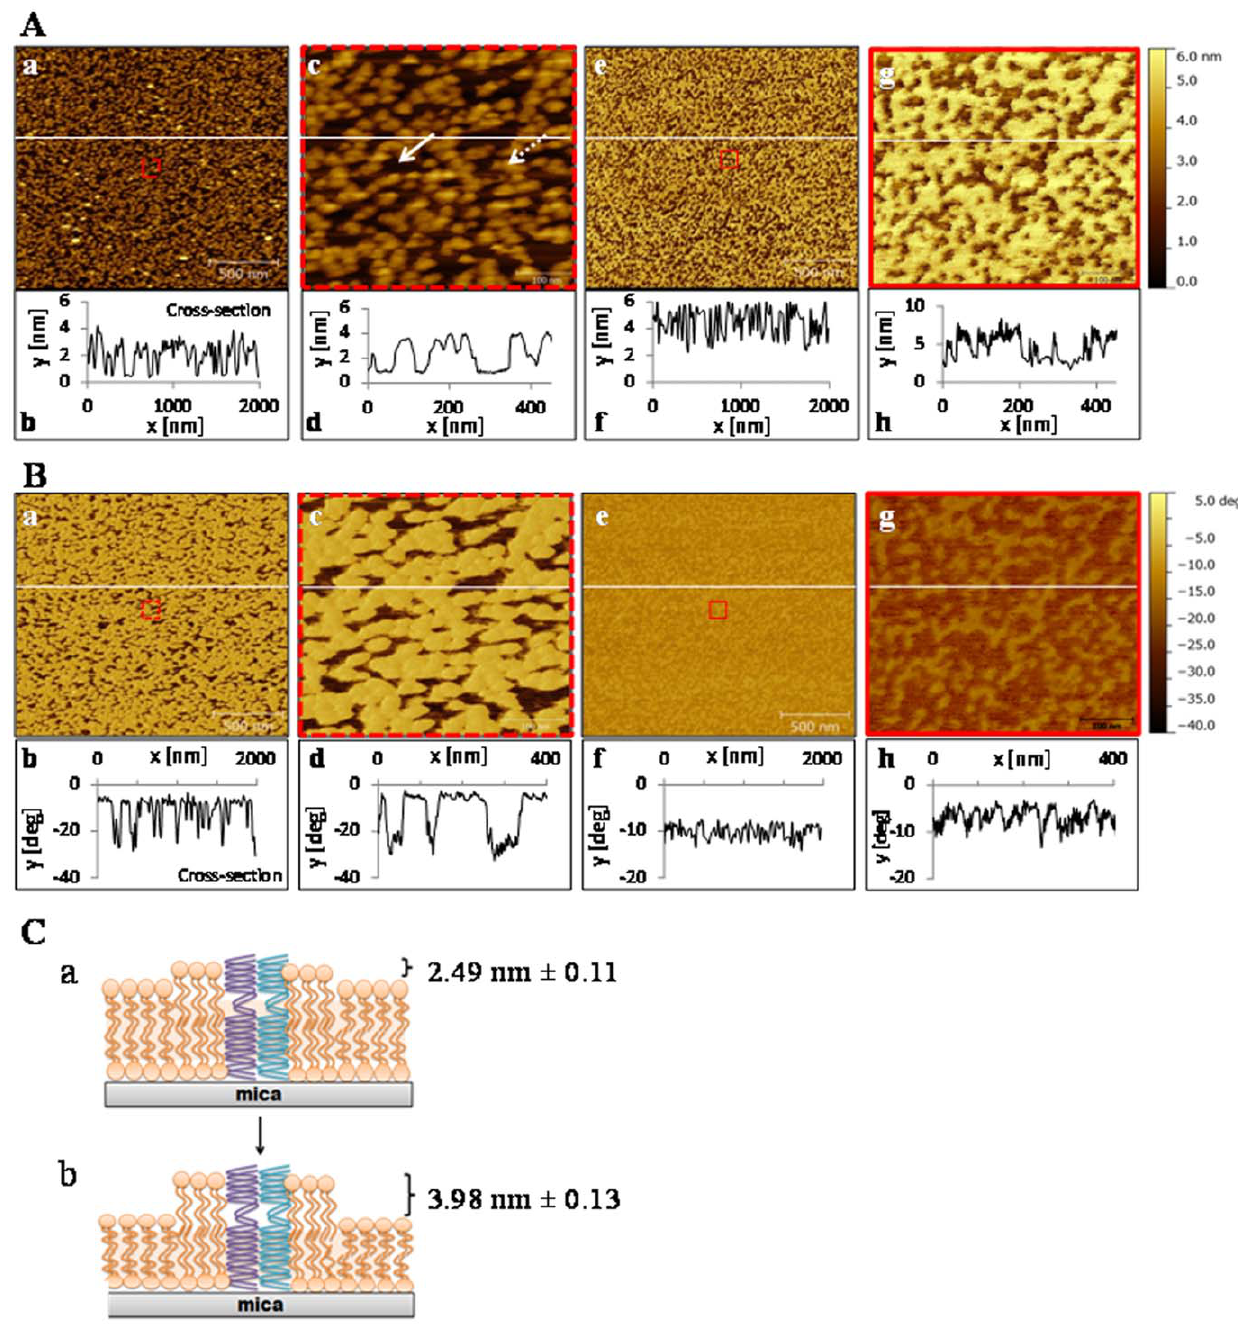
Figure 2. Cortisol effect on liver plasma membrane topography and surface adhesion. A) Representative atomic force microscopy (AFM) images of supported hepatic plasma membrane topography (membrane height). Images were taken prior to (a) and 30 min after cortisol (100 ng/ mL) treatment (e) in liquid cell at room temperature. A zoomed in scan is also shown for the control (c) and cortisol treated (g) membranes that was scanned for 60 min. The approximate scan region of the zoomed in image is indicated by the dashed red box in the control image (a) and solid red box in the cortisol-treated image (e). Two distinct domains, which differ in height, are visible in both control and cortisol-treated membranes. A representative higher domain is indicated by the dotted arrow, while the lower domain is indicated by the solid arrow (c). Short-term cortisol treatment altered the topography of the plasma membrane. The cross-section graph featured below each image was calculated from points along the white horizontal line. The y-axis represents vertical height (nm), whereas the x-axis represents the horizontal distance (nm). B) Representative AFM images of supported hepatic plasma membrane phase (surface adhesion properties). Images were taken prior to (a) and 30 min after cortisol (100 ng/mL) treatment (e) in liquid cell at room temperature. A zoomed in scan is also shown of the control (c) and cortisol treated (g) membranes that was scanned for 60 min. The approximate scan region of the zoomed in image is indicated by the dashed red box in the control image (a) and solid red box in the cortisol-treated image (e). Two distinct domains, which differ in their viscoelastic (surface adhesion) are visible in both control and cortisol-treated membranes. Acute cortisol treatment altered the viscoelastic properties of the plasma membrane within 30 min of treatment. The cross-section graph featured below each image was calculated from points along the white horizontal line. The y-axis represents degree of deflection (degrees), whereas the x-axis represents the horizontal distance (nm). C) A schematic representation of cortisol’s effect on plasma membrane